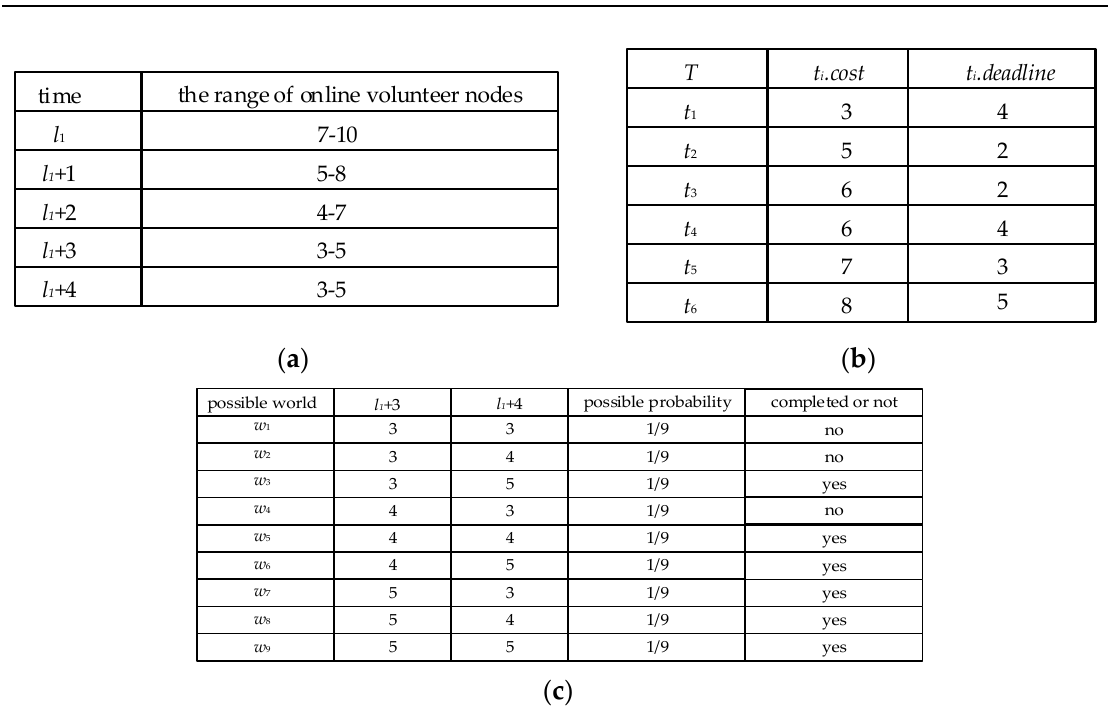
Figure 6. Task classification and corresponding priority. The specific ways of division are as follows: If the computational cost of task t is less than the average computational cost of all tasks in the task list, and t . deadline is less than the middle time of the whole computing time, it is considered that the task t is simple and urgent, and the task priority corresponding to t is 1. If the computational cost of the task t is less than the average computational cost of all tasks in the task list, and t . deadline is greater than the middle time of the whole computing time, it is considered that task t is a simple task, and the task priority corresponding to t is 2. If the computational cost of task t is greater than the